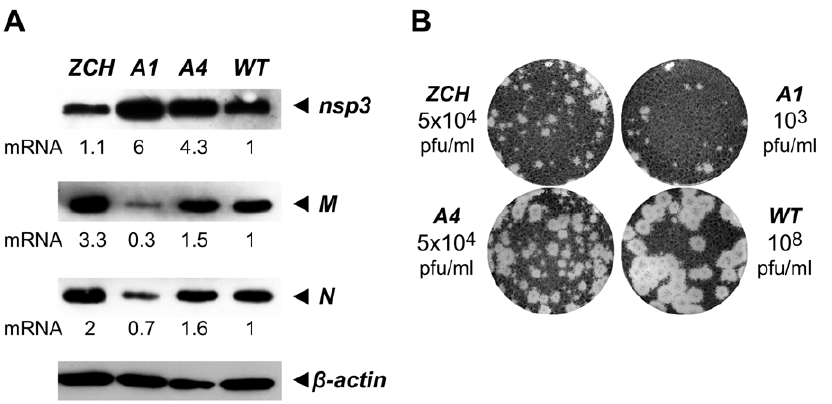
Figure 6. Analysis of viral protein accumulation and virus production by selected nsp1 mutants. (A) Western blot analysis of EAV-specific protein accumulation. Cells transfected with wt or mutant viral genomes were harvested 11 h after transfection and equal amounts of total protein were analyzed with EAV-specific sera detecting nsp3, M and N, which are translated from RNAs 1, 6 and 7, respectively. The relative levels of each mRNA template (derived from Fig. 4B) are indicated below the gels. Beta-actin was used as a loading control. (B) Plaque phenotype and virus titers of the ZCH, A1 and A4 mutants in comparison with wt. Plaque assays were performed on BHK-21 using cell culture supernatants harvested 24 h after transfection. Virus titers represent an average of three independent experiments.